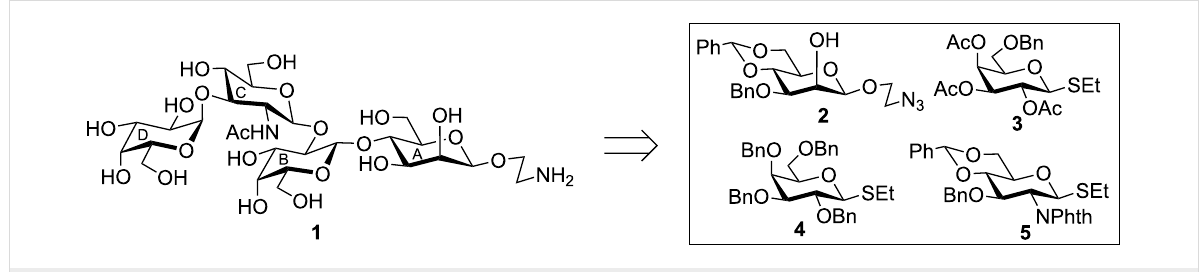
Figure 2: Structure of the synthesized tetrasaccharide 1 and its synthetic